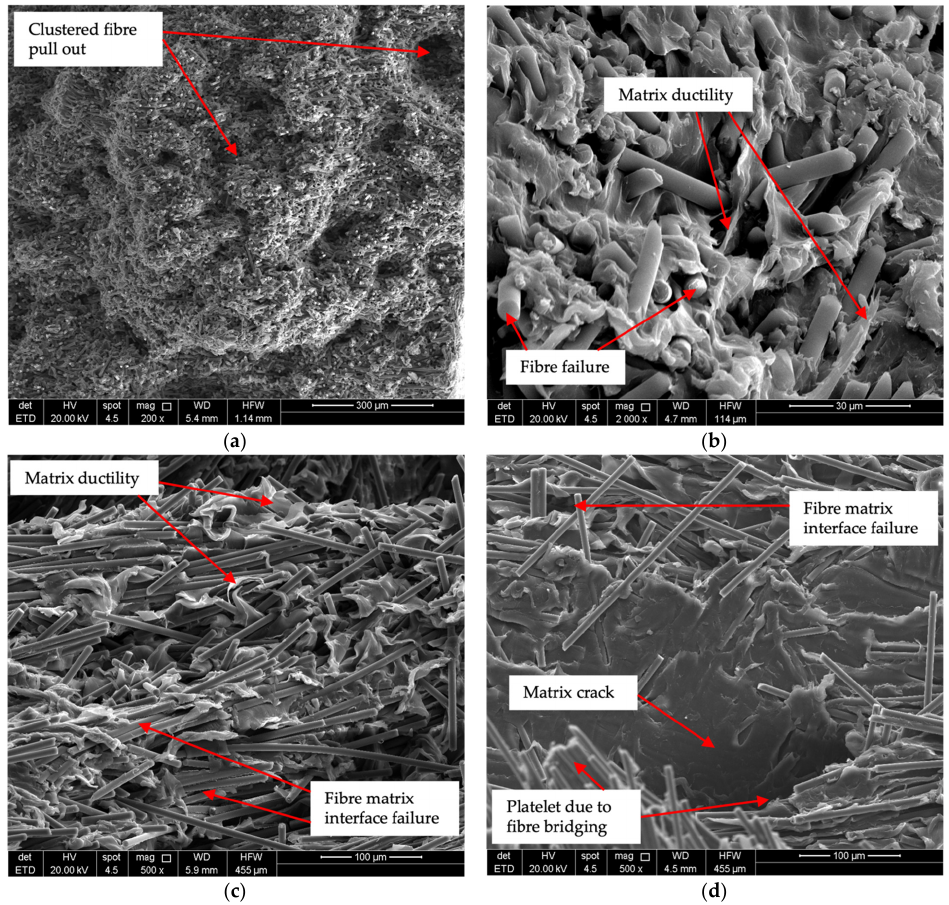
Figure 7. Fatigue fracture surfaces at 120 ◦ C under fully reversed loading ( a ) SCF N f = 2891; ( b ) SCF N f = 390,023; ( c ) LCF N f = 13,791; ( d ) LCF N f =